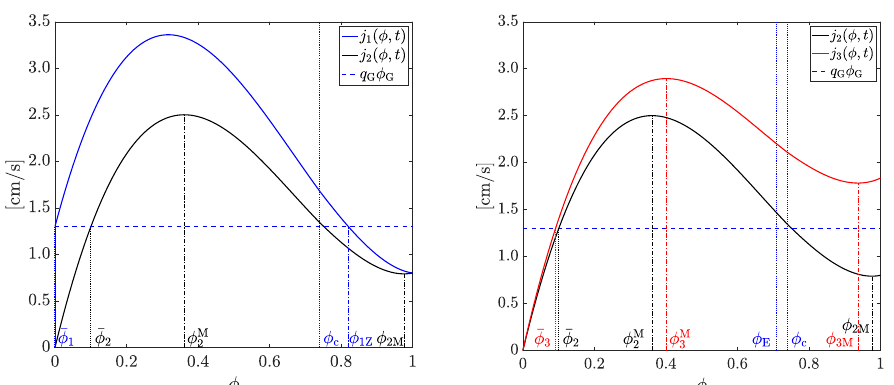
Figure 6. Possible steady-state values ¯ φ 2 satisfying condition (18) for zone 2 ( left ) and ¯ φ 3 satisfy- ing (23) for zone 3 ( right ). Note that, in zone 1, we suppose ¯ φ 1 = 0, since we suppose that that no bubbles leave through the underflow. These graphics were obtained using φ G = 1, φ F = 0, q U = 0.5cm/s, q G = 1.3cm/s, q F = 1.035cm/s and q W =